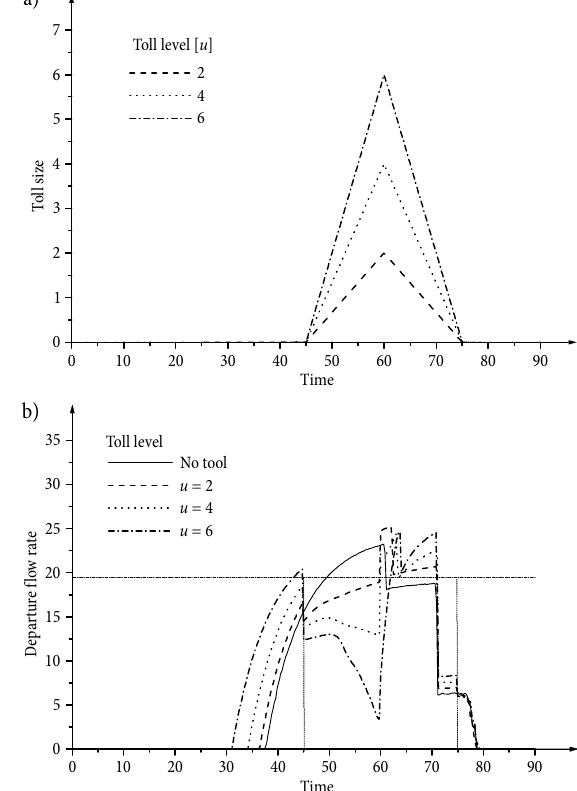
Fig. 8. Solution profiles from the second type of toll profiles: a – toll profiles; b – departure